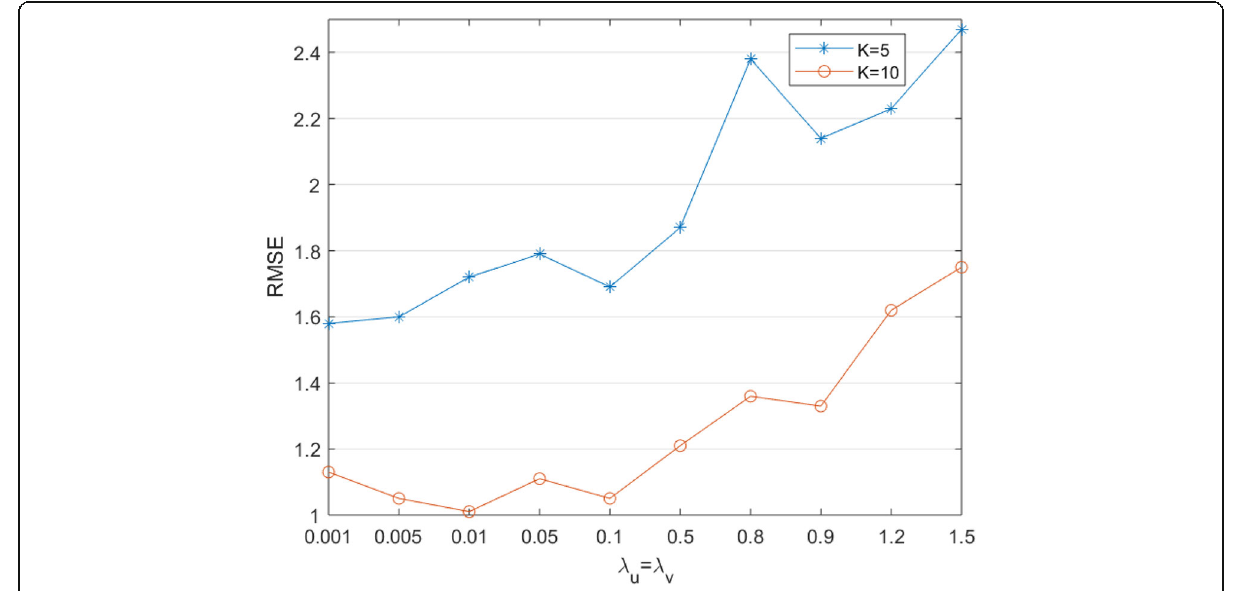
Fig. 3 RMSE vs. λ u and λ v on Ciao . The blue line with K = 5, and the green line with K = 10